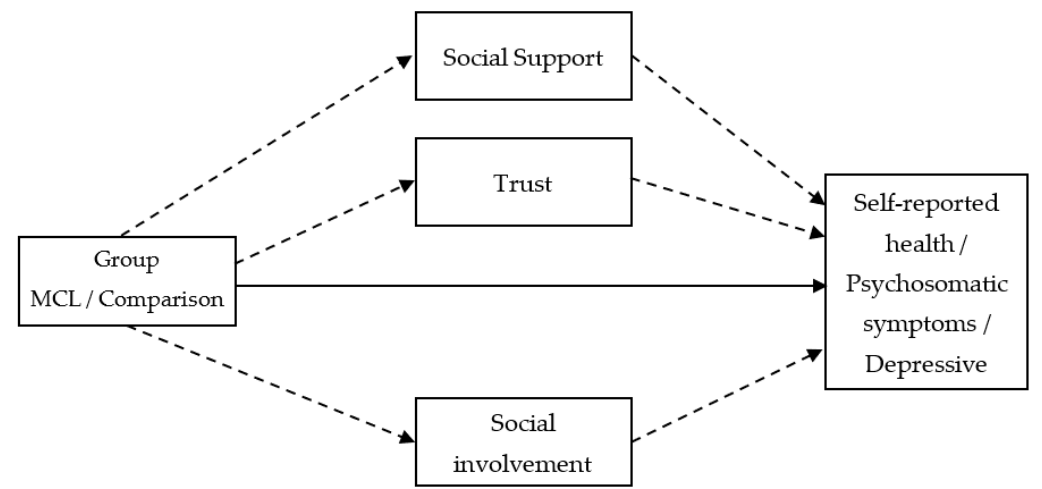
Figure 1. The parallel mediation models tested direct and indirect effects. Note: Group-Comparison (0)/MCL (1); Full line-direct effect; Dashed line-indirect effect.